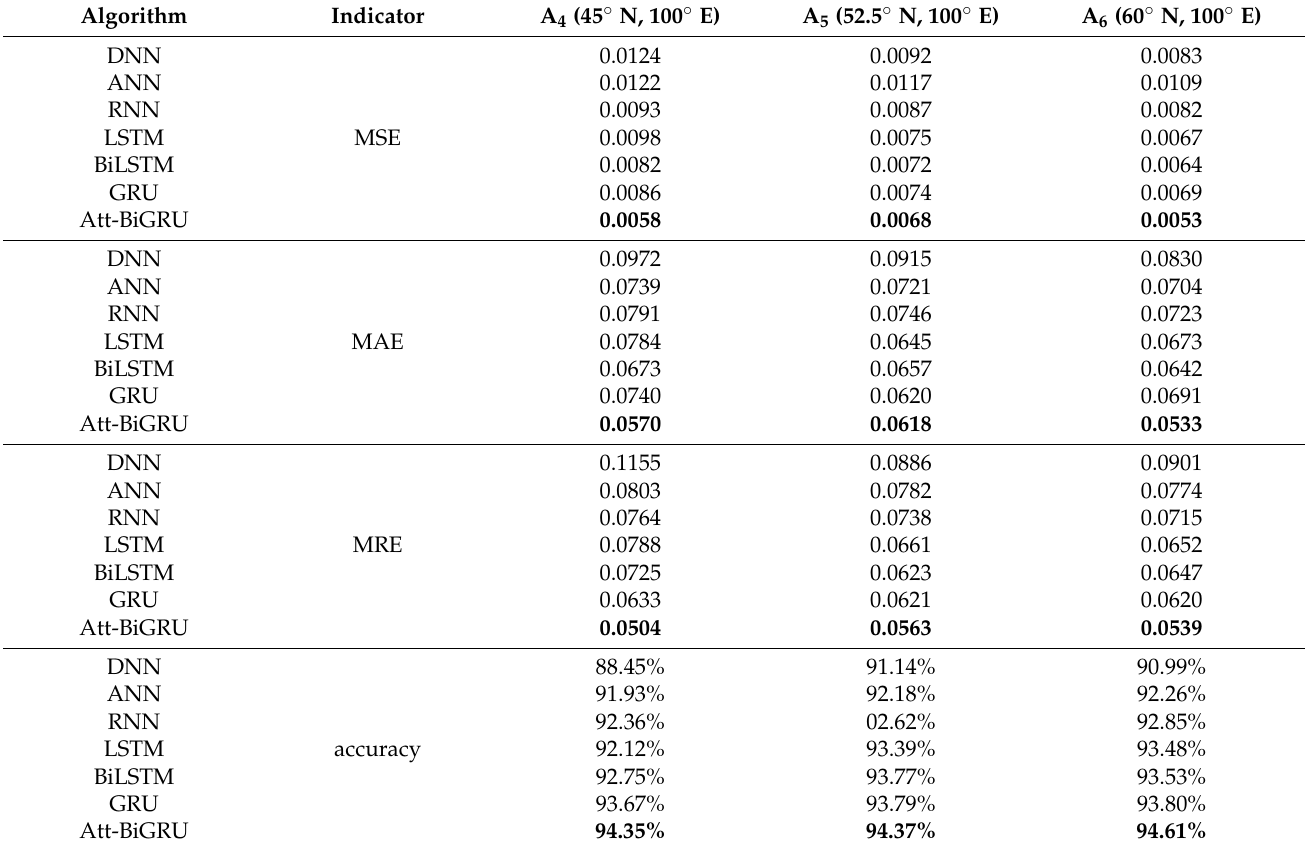
Table 7. Comparison of five methods in three middle latitude